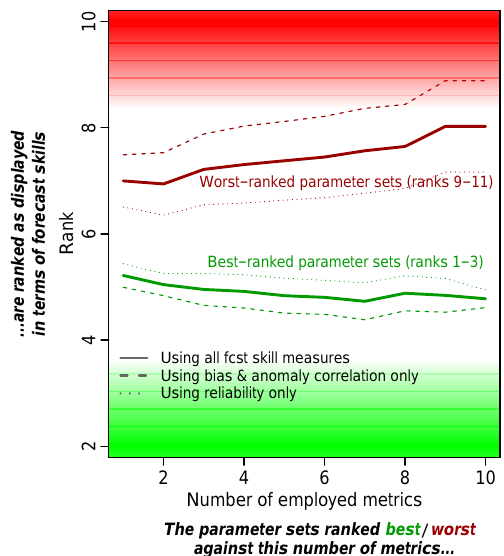
Red curve here in case of perfect obs & model